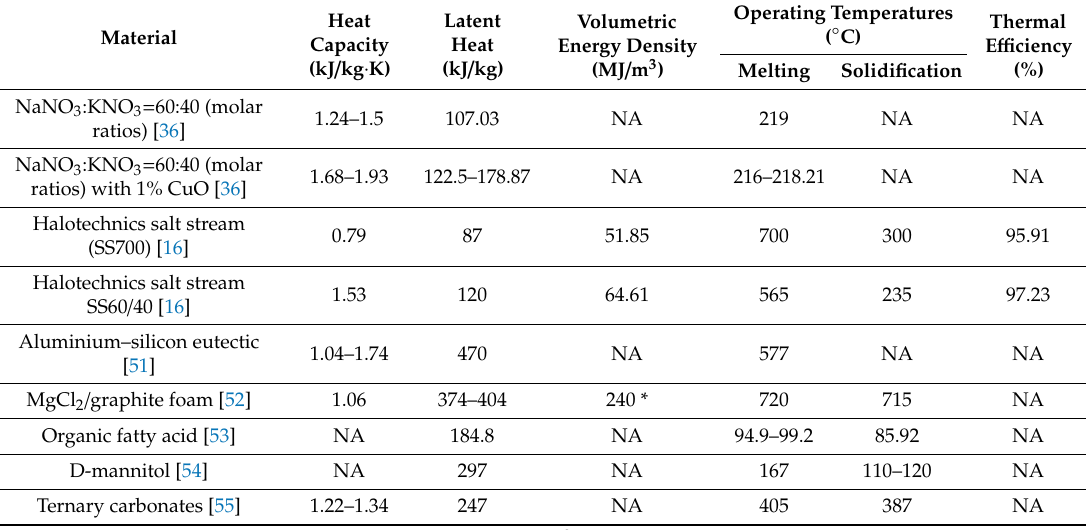
Figure 2. Design of heliostat type concentrated solar power (CSP) plant [45]. (Reprint with permission [45]; 2019, Elsevier.) Table 2. Summary of the material properties of newly investigated phase change materials (PCMs).